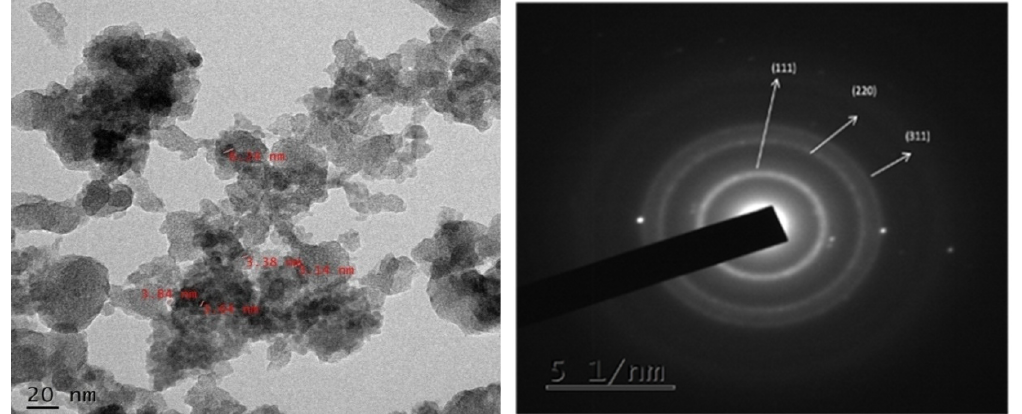
Fig. 5. TEM image (a) and SAED pattern (b) of Zr doped CdSe